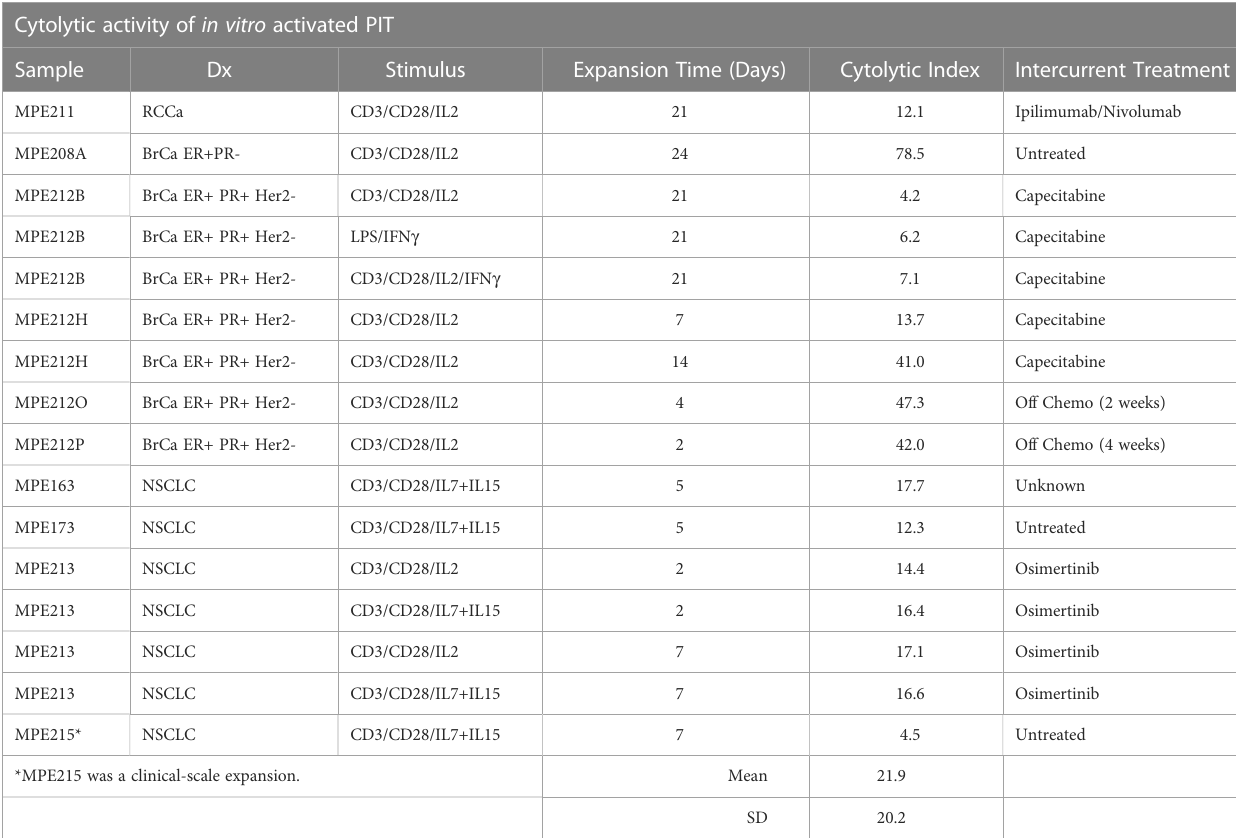
TABLE 1 Cytotoxicity of in vitro activated, culture expanded MPE T cells against autologous tumor. Cytolytic activity of in vitro activated PIT